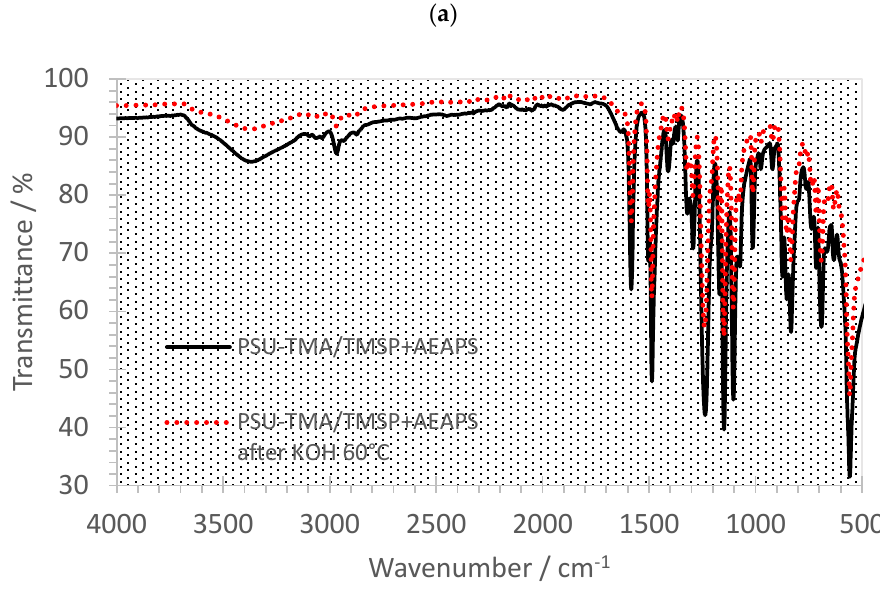
Figure 5. FTIR spectra of PSU-TMA membranes with silica network. ( a ) PSU-TMA/TMSP and ( b ) PSU-TMA/TMSP/AEAPS. Black curves: before treatment in KOH at 60 °C; red curves: after 24 h treatment in KOH 60 °C.